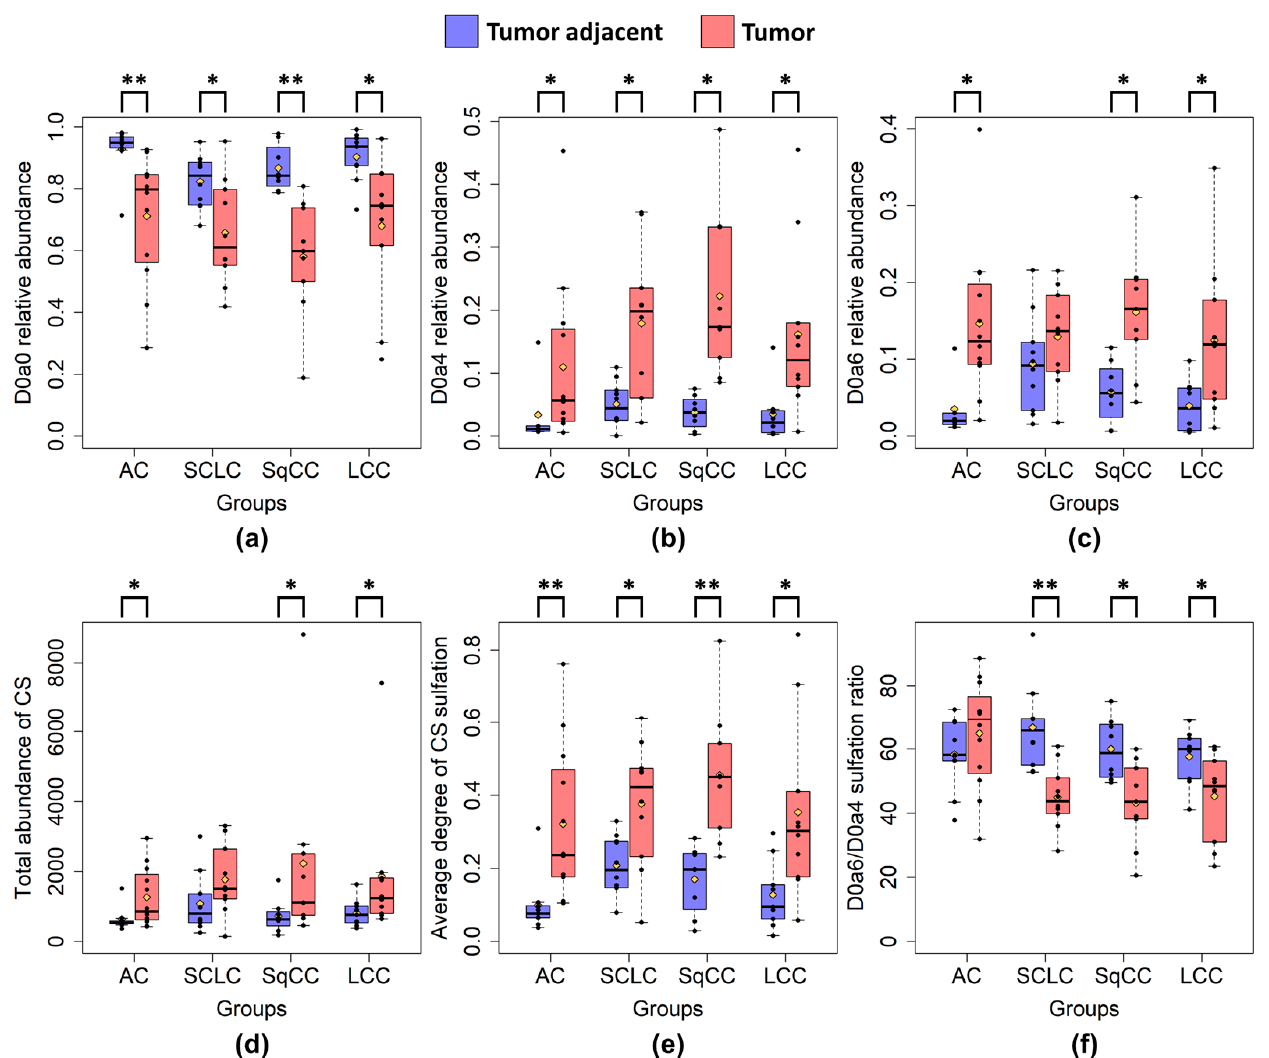
Figure 5. Altered CS sulfation characteristics between the tumor and adjacent samples. ( a ): D0a0 relative abundance; ( b ): D0a4 relative abundance; ( c ): D0a6 relative abundance; ( d ): total CS quan- tity; ( e ): average degree of CS sulfation; ( f ): 6- O -/4- O -sulfation ratio. Blue boxes represent tumor- adjacent normal samples, while red boxes represent tumor samples. (AC: adenocarcinoma; SCLC: small cell lung cancer; SqCC: squamous cell carcinoma; LCC: large cell carcinoma). The yellow dia- monds are the average values of the given sample groups. (*: p < 0.05; **: p < 0.01).